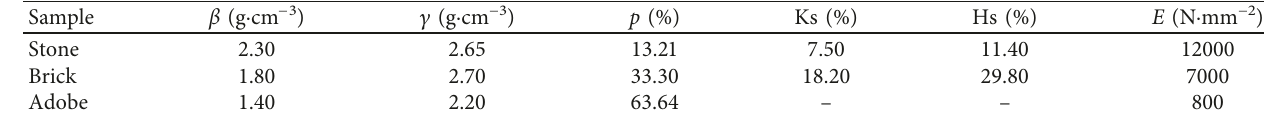
Figure 5: The masonry infill materials of the studied houses. (a) Adobe. (b) Stone. (c) Brick. Table 2: Physical and mechanical properties of infill